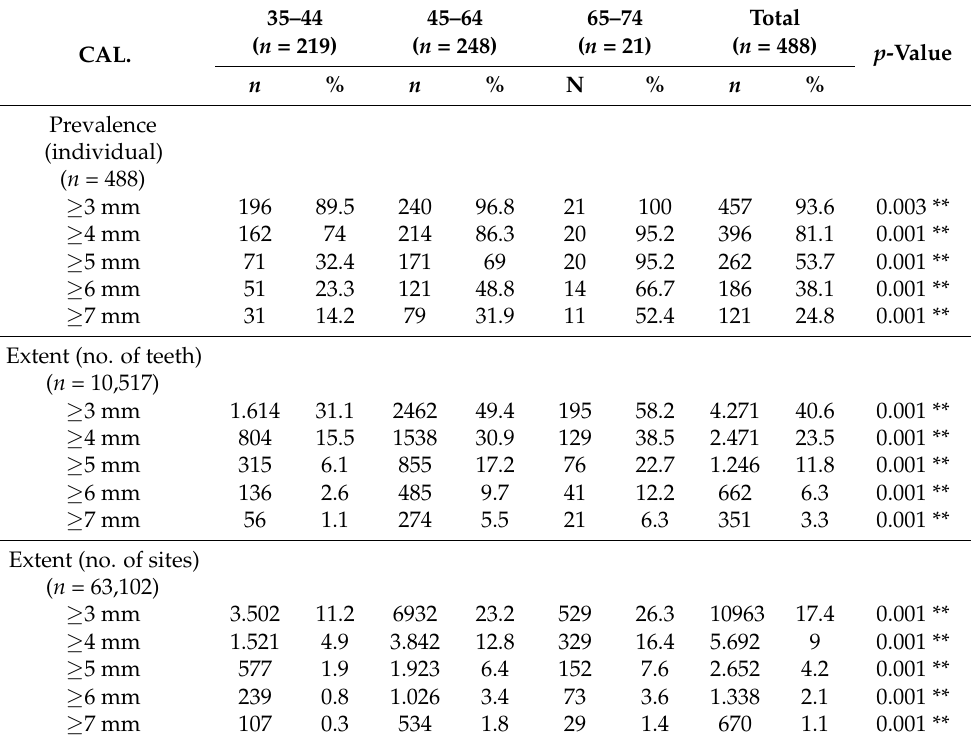
Table 4. The prevalence and extent of teeth and sites meeting the threshold values of clinical attachment loss by age